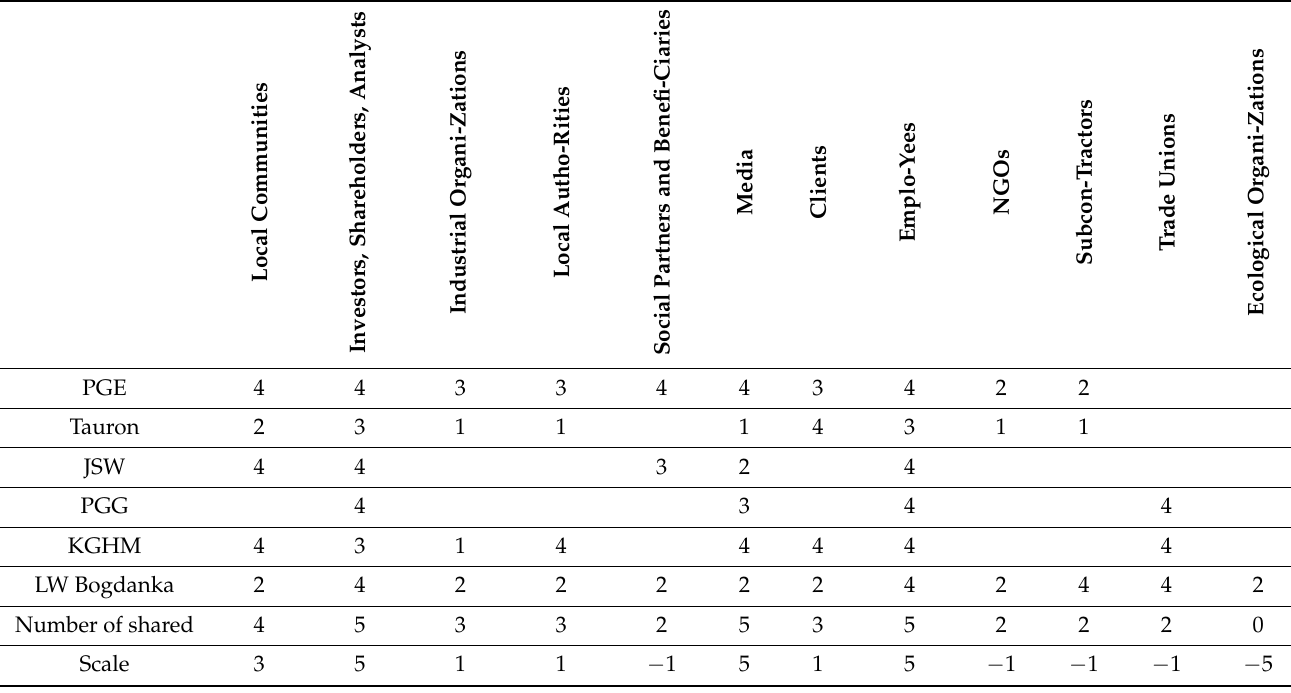
Table 6. The levels of interest of the local stakeholders in mining and energy companies in